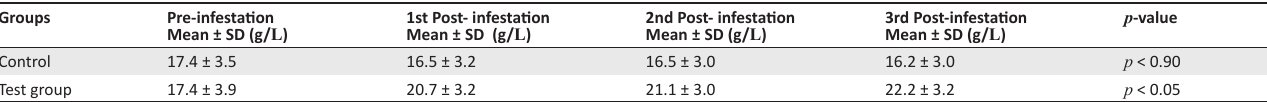
TABLE 2: Gamma globulin levels (g/ L ) in the serum of the test and control cross-bred goats (South African Indigenous goats X Saanen) before and after three consecutive infestations of Rhipicephalus appendiculatus adult ticks. Groups